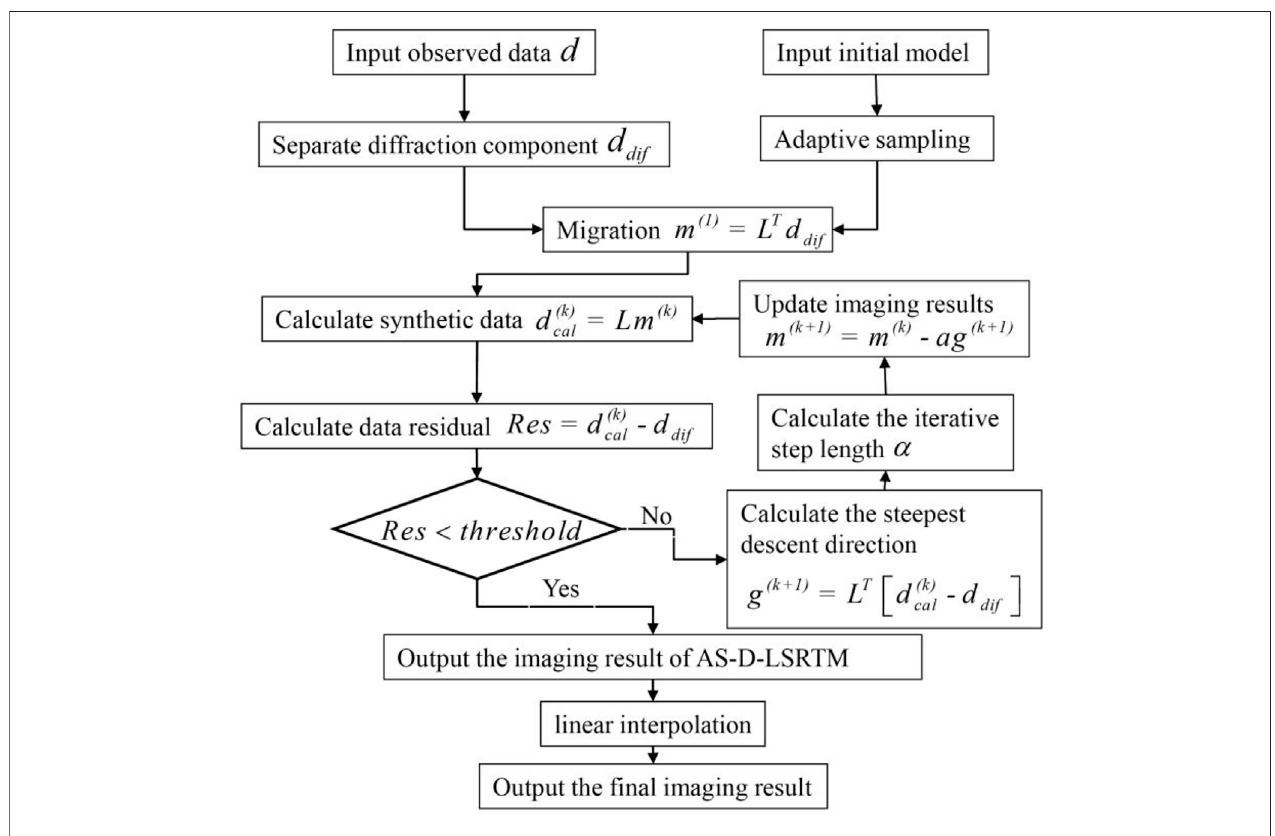
FIGURE 3 | Work fl ow of AS-D-LSRTM.